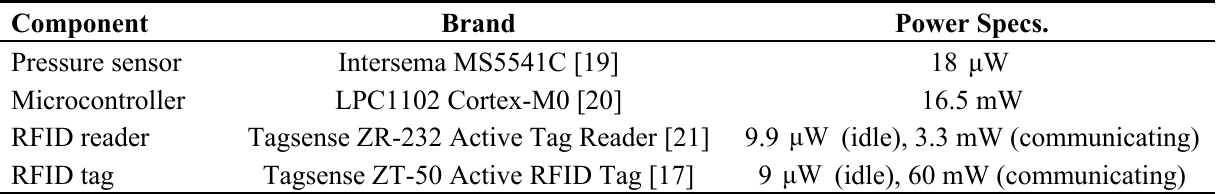
Table 4. Sensor node components and typical power